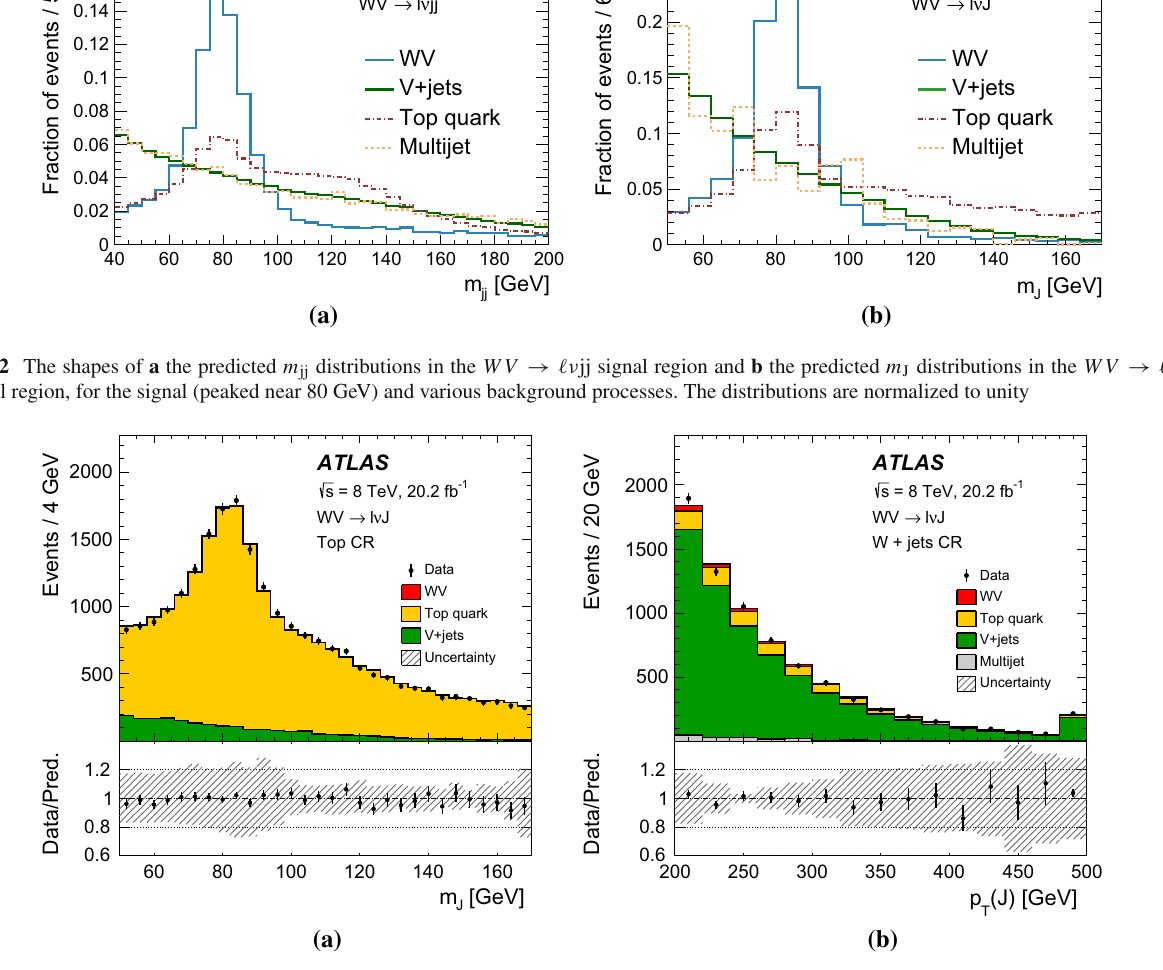
Fig. 3 Comparison between data and prediction in the WV → (cid:4)ν J channel for a m J in the top CR, and b p T ( J ) in the W + jets CR. A scale factor is applied to the top-quark background prediction in the top CR and the W + jets CR, and a scale factor is applied to the W + jets